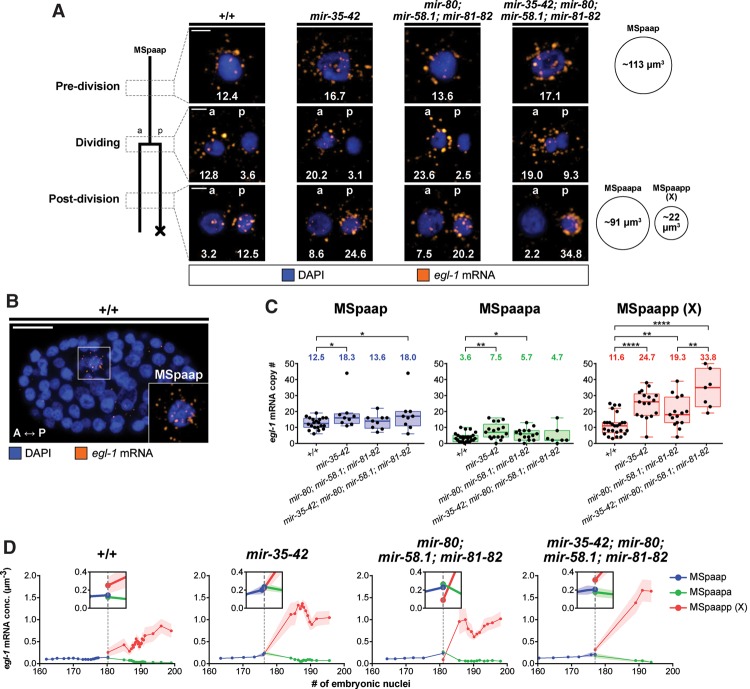
egl-1 mRNA levels are temporally dynamic in the MSpaap lineage and more abundant in mir family mutants. (A) smRNA FISH analysis in the MSpaap lineage. The lineage is illustrated at the right, with the approximate time of each analysis (predivision, dividing, and post-division) indicated. Representative images of the MSpaap cell and its daughters are shown for each time point in four genetic backgrounds, as indicated. Nuclei are labeled as belonging to the surviving daughter (anterior [a]) or the dying daughter (posterior [p]). The egl-1 mRNA copy number corresponding to each image is given. Approximate cellular volumes are given at the right. Bars, 2 µm. (B) A fixed wild-type embryo containing 167 nuclei showing the MSpaap cell (inset). The anterior–posterior axis (A ↔ P) is indicated Bar, 10 µm. (C) Quantification of egl-1 mRNA in the MSpaap cell and its two daughters (MSpaapa and MSpaapp [X]) for each of the indicated genotypes. The mean value is given above each data set. Box and whiskers were plotted according to Tukey's test. (*) P < 0.05; (**) P < 0.01; (****) P < 0.0001 via Mann-Whitney test. (D) Developmental time course showing egl-1 mRNA concentration in cells of the MSpaap lineage for the indicated genotypes. Division of the MSpaap cell is indicated by a vertical dashed line. Insets show a 2× zoom of the graph at the time of division. Graphs were generated from raw data as a centered moving average of order 5. Shaded areas represent SEM, when applicable. The following alleles were used: mir-35-41(nDf50), mir-42 (nDf49), mir-80(nDf53), mir-58.1(n4640), and mir-81-82(nDf54).